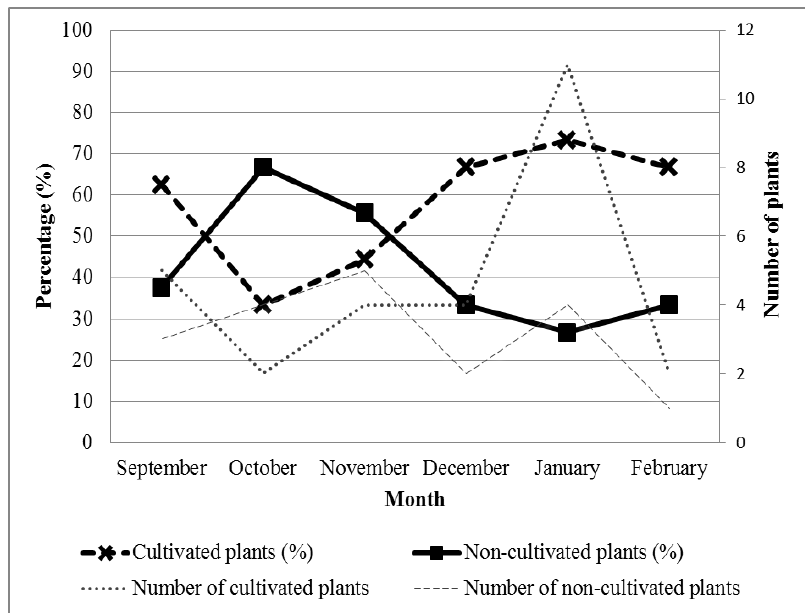
Figure 3: Life forms of plants which were identified from elephant dung piles.